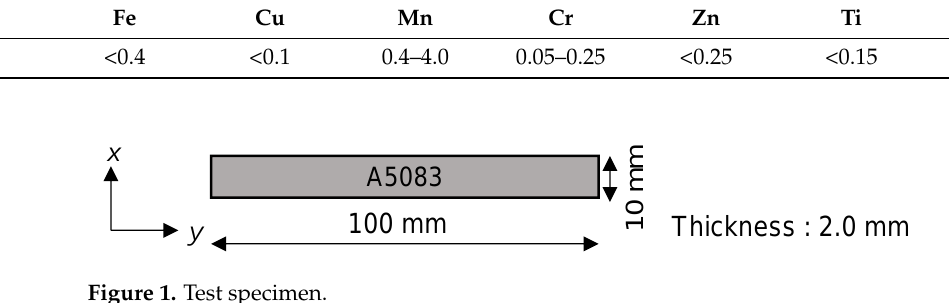
Figure 1. Test Figure 1. Test specimen. Table 1. Chemical composition of AA5083 (mass %).